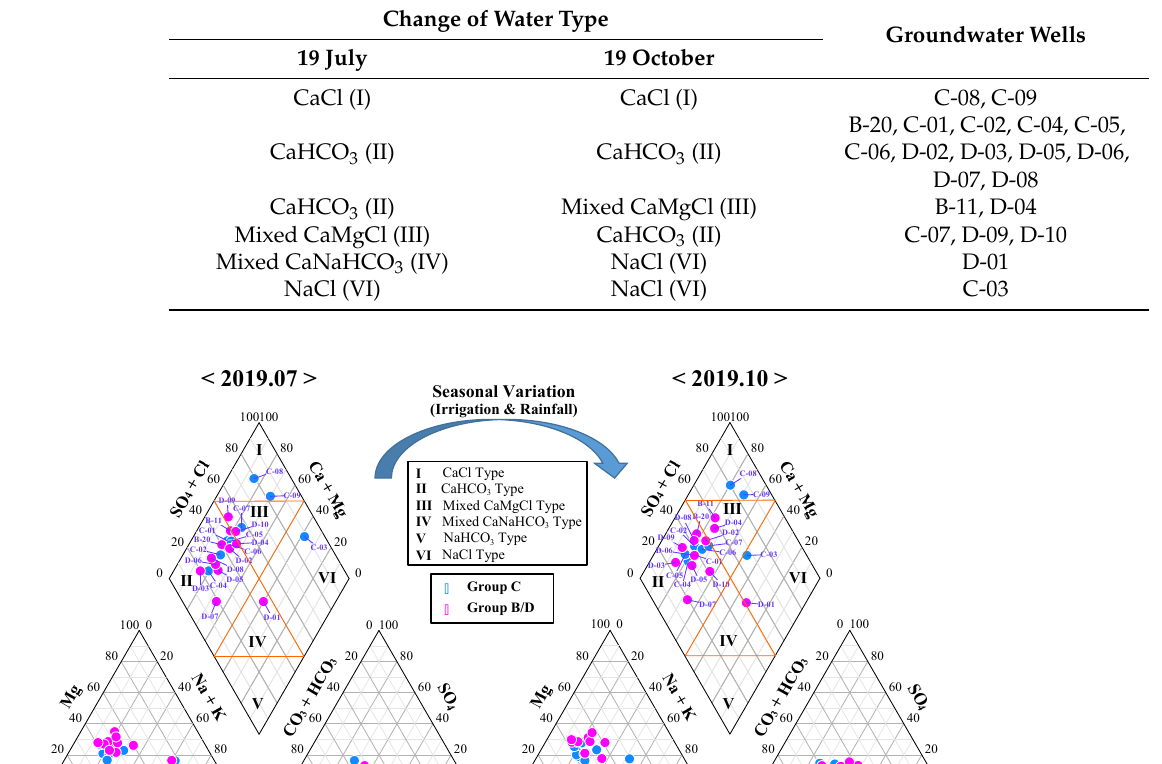
Table 4. Change of water types for groundwater samples in the study area.